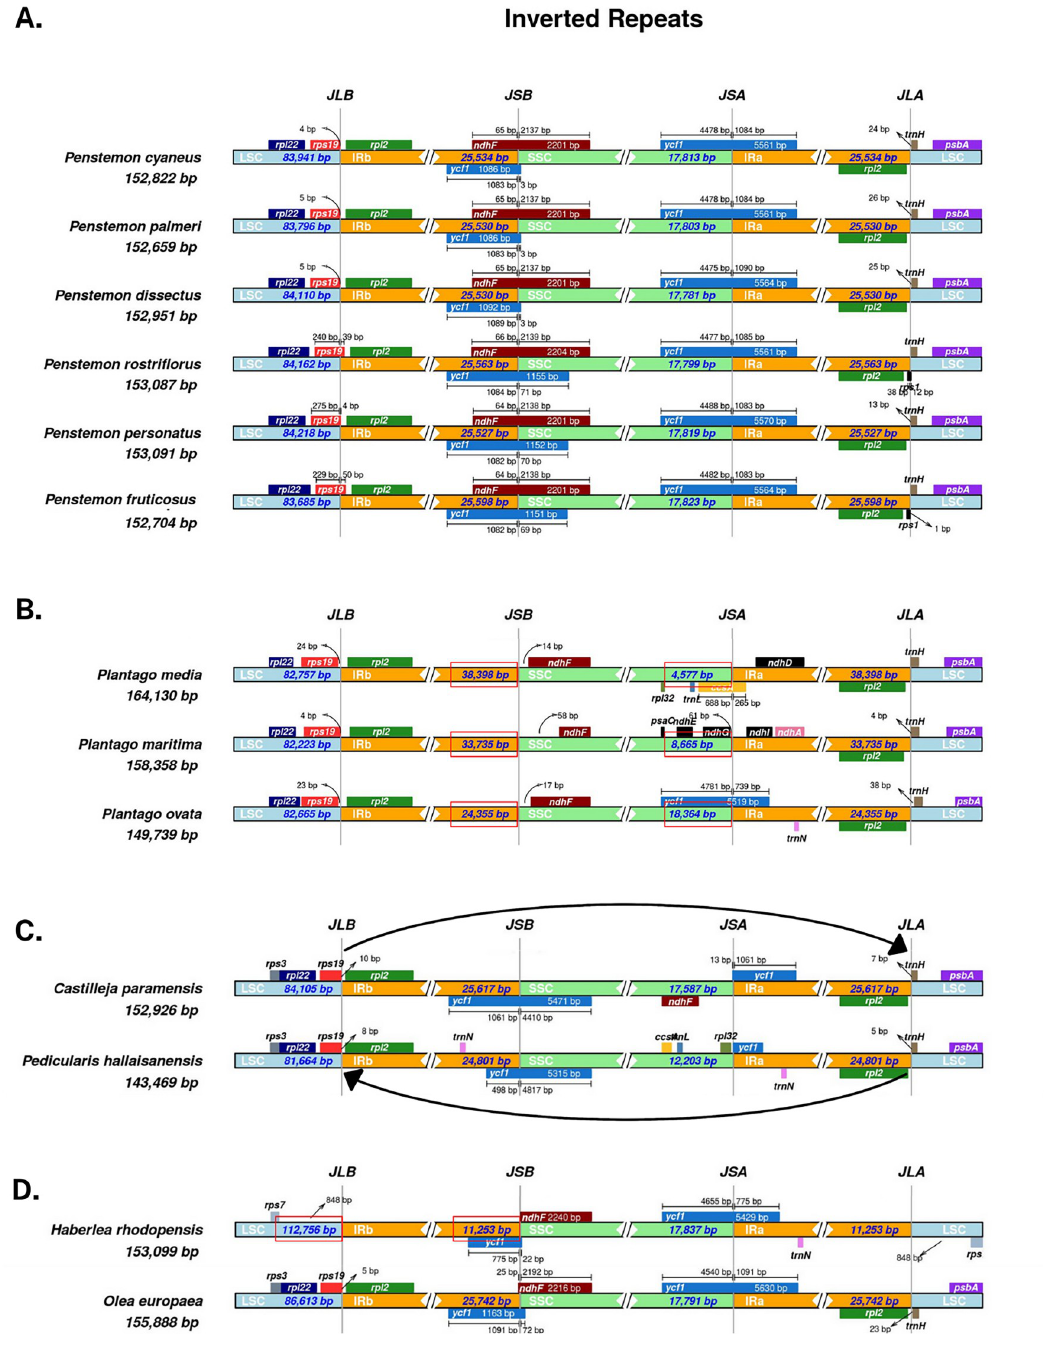
Fig 3. IRScope visualizations of inverted repeat (IR) and short-single copy (SSC) junctions. A. Variation among Penstemon taxa: the ycf1 fragment at the SSC-IRb junction (JSB) in P . dissectus , P . palmeri , and P . cyaneus . B. Successive expansions of the IR regions into the SSC region observed in the genus Plantago . C. Total inversion of the IRa-SSC-IRb plastome segment in the Orobanchaceae genera C . paramensis and P . hallaisanensis . D. A reduction in IR length associated with an expansion of the LSC region in H . rhodopensis compared to our basal lineage, Olea europaea